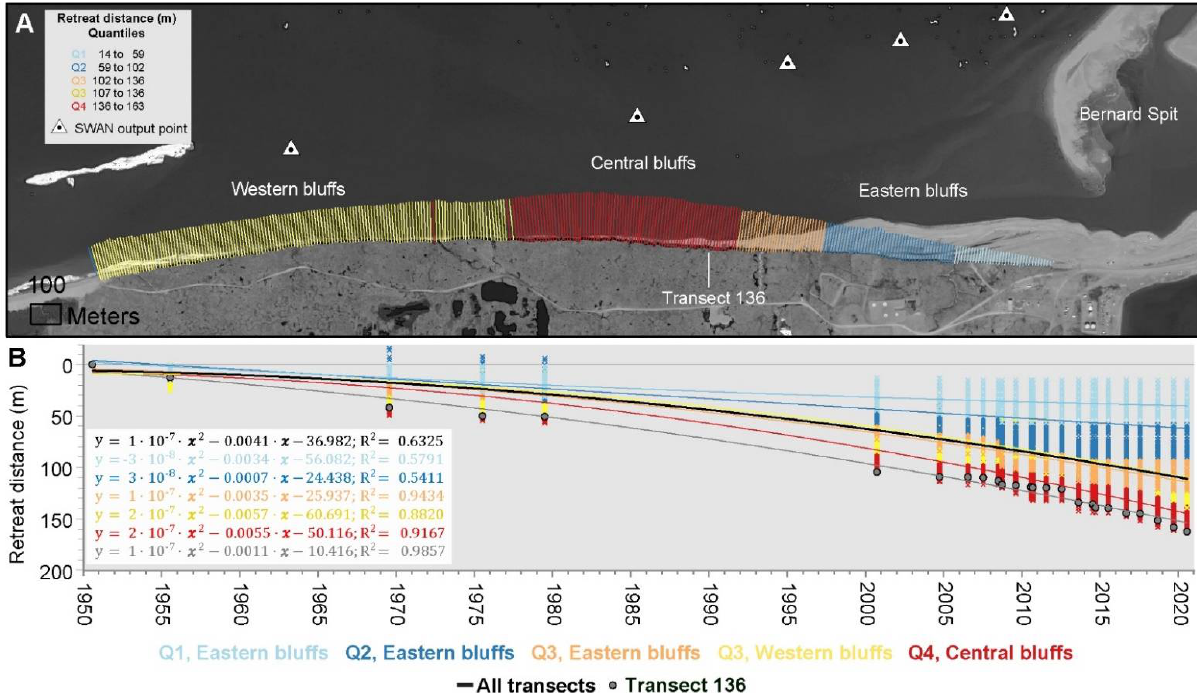
Figure 7. ( A ) Quartile distribution of bluff retreat distance identified by separate colors: Central bluffs (Q4), Western bluffs (Q3), and Eastern bluffs, which are further subdivided by moderate (Q3), low (Q2), and very low (Q1) retreat rates. ( B ) Cumulative bluff retreat distances for all transects within a region and at each observational time period and equations for polynomial linear regression and R 2 values. Imagery base is modified from Alaska High Resolution Imagery RGB (https://gis.data.alaska.gov/pages/Imagery%20Program accessed on 1 October 2021).